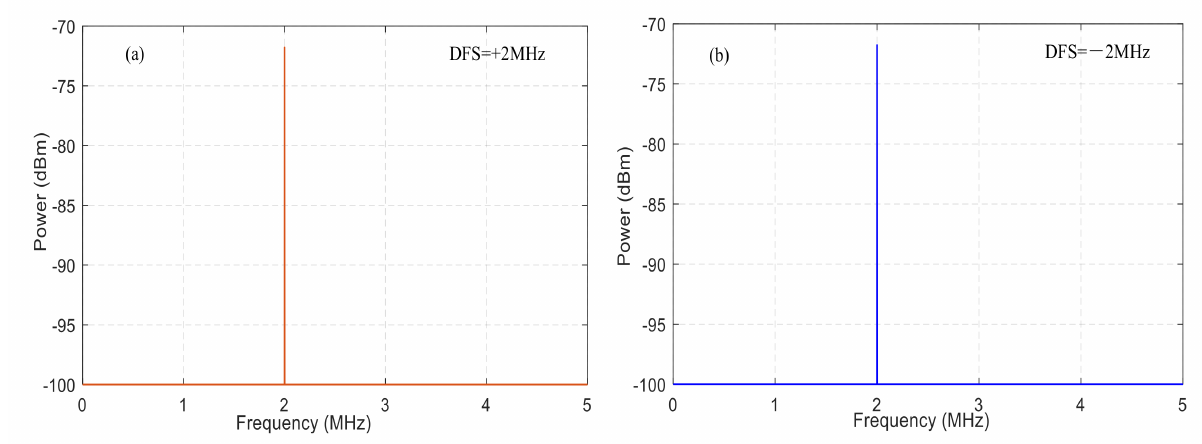
Figure 4. The electrical spectra in the upper branch for the DFSs at ( a ) +2 MHz and at ( b ) − 2